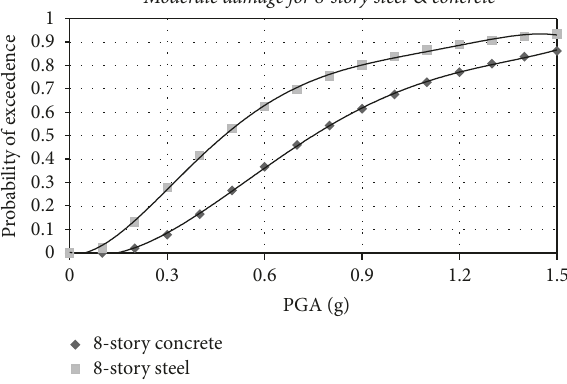
Figure 8: Comparison of the fragility of the 8-story steel and RC frame buildings for the moderate damage